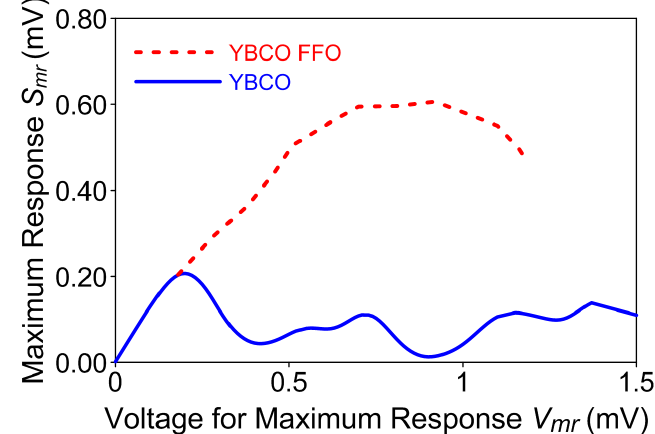
Figure 7. The maximum response depending on YBCO voltage for bicrystal junction with the length L = 50 µ m for phase rotation regime (blue solid curve) and traveling wave regime (red dashed